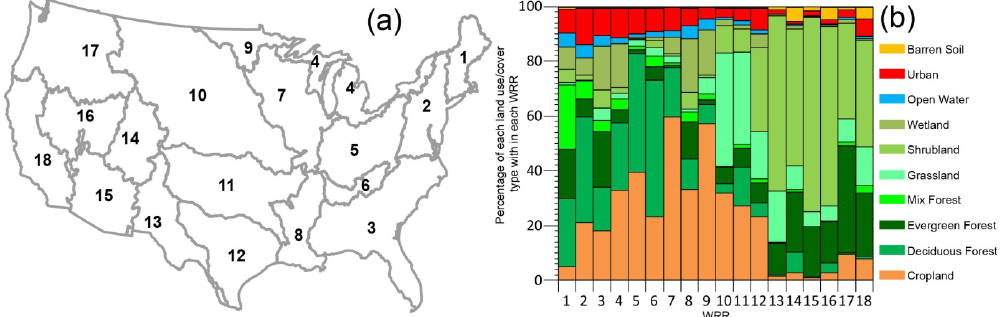
Figure 1. Location of the Water Resource Regions (WRRs) over the CONUS (a) with the percentage of each land use/cover type within each WRR. The numeral from 1 to 18 in panel (a) represents the number of WRR. In panel (b) , the rectangle size notes the percentage of each land use/cover type within each WRR. Note that the percentages of each land use/cover type were calculated based on the 2006 National Land Cover Database (NLCD) of